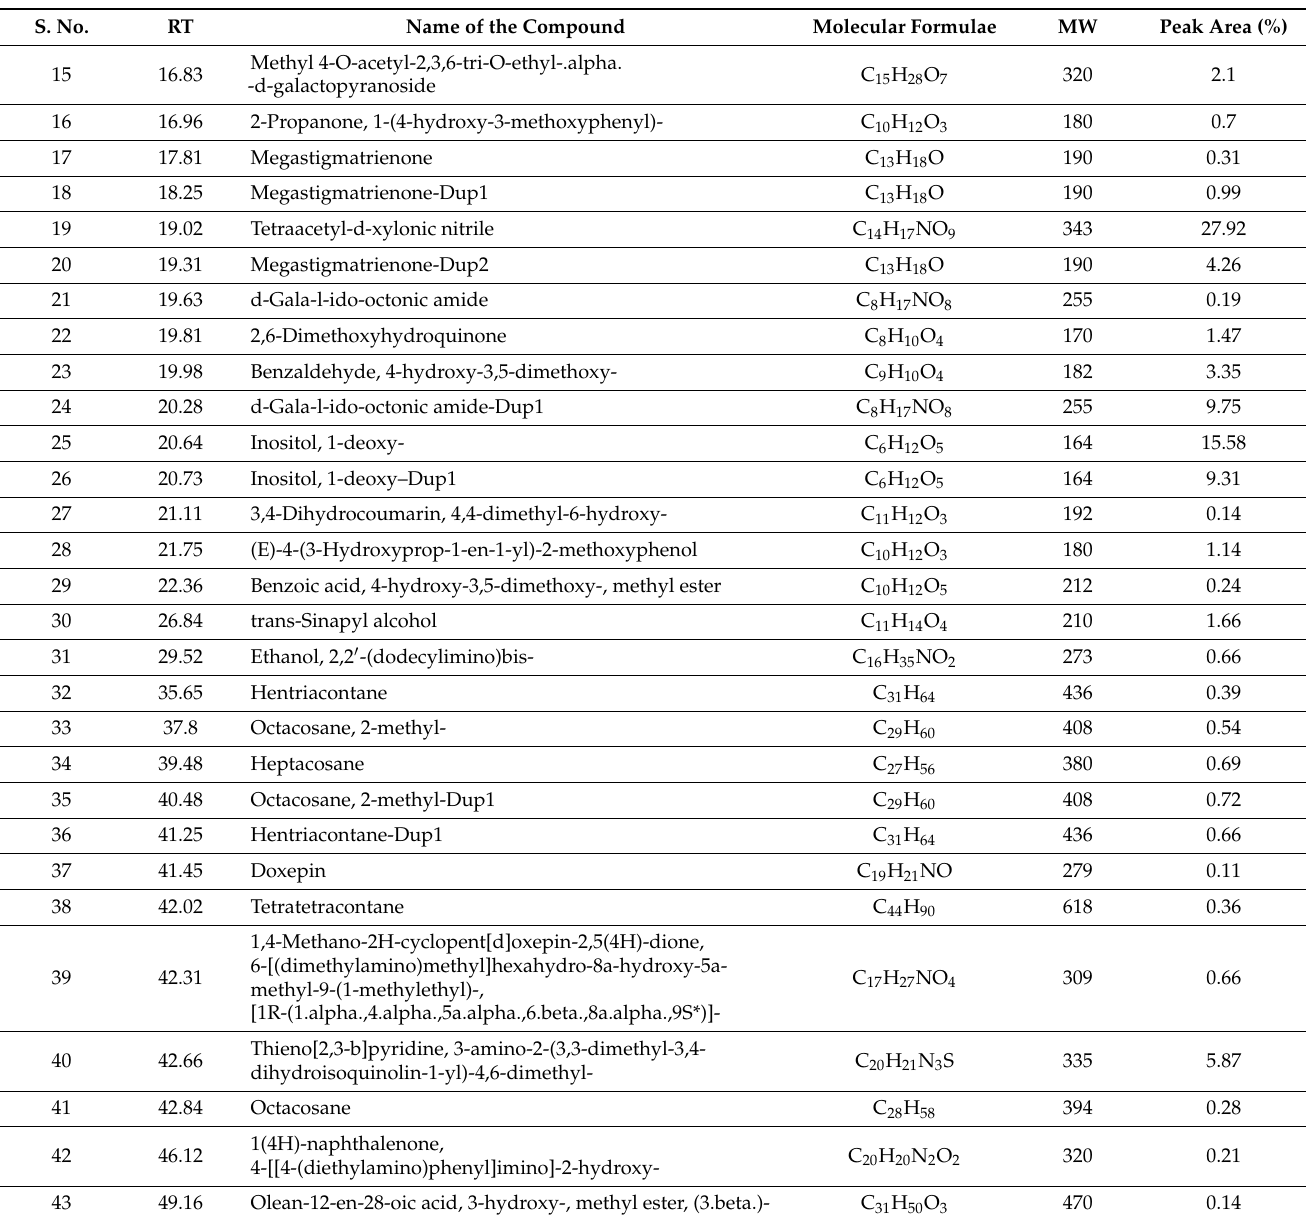
The water extracted from C. tinctorius contained about 17 different compounds. Benzo- furan, 2,3-dihydro-, with a molecular weight of 120 and a chemical formula of C 8 H 8 O, had the most remarkable peak area percent of 23.24 among the seventeen compounds detected. The second most significant peak was found with 3-Isopropoxy-1,1,1,7,7,7-hexamethyl- 3,5,5-tris(trimethylsiloxy)tetrasiloxane, with a molecular weight of 576 and a chemical formula of C 18 H 52 O 7 Si 7, with a summative peak area percent of 21.23. The following compounds of 3,4-Dihydroxyphenylglycol, 4TMS derivative; 4H-Pyran-4-one, 2,3-dihydro- 3,5-dihydroxy-6-methyl-; and Cyclohexasiloxane, dodecamethyl- had moderate peak area percent. Their respective values of peak area were 8.94, 8.56, and 6.96. C 20 H 42 O 4 Si 4 /458, C 6 H 8 O 4 /144, and C 12 H 36 O 6 Si 6 /444 are their chemical formulas and molecular weights. The compounds with the lowest peak area percent are presented in Table 4 and Figure